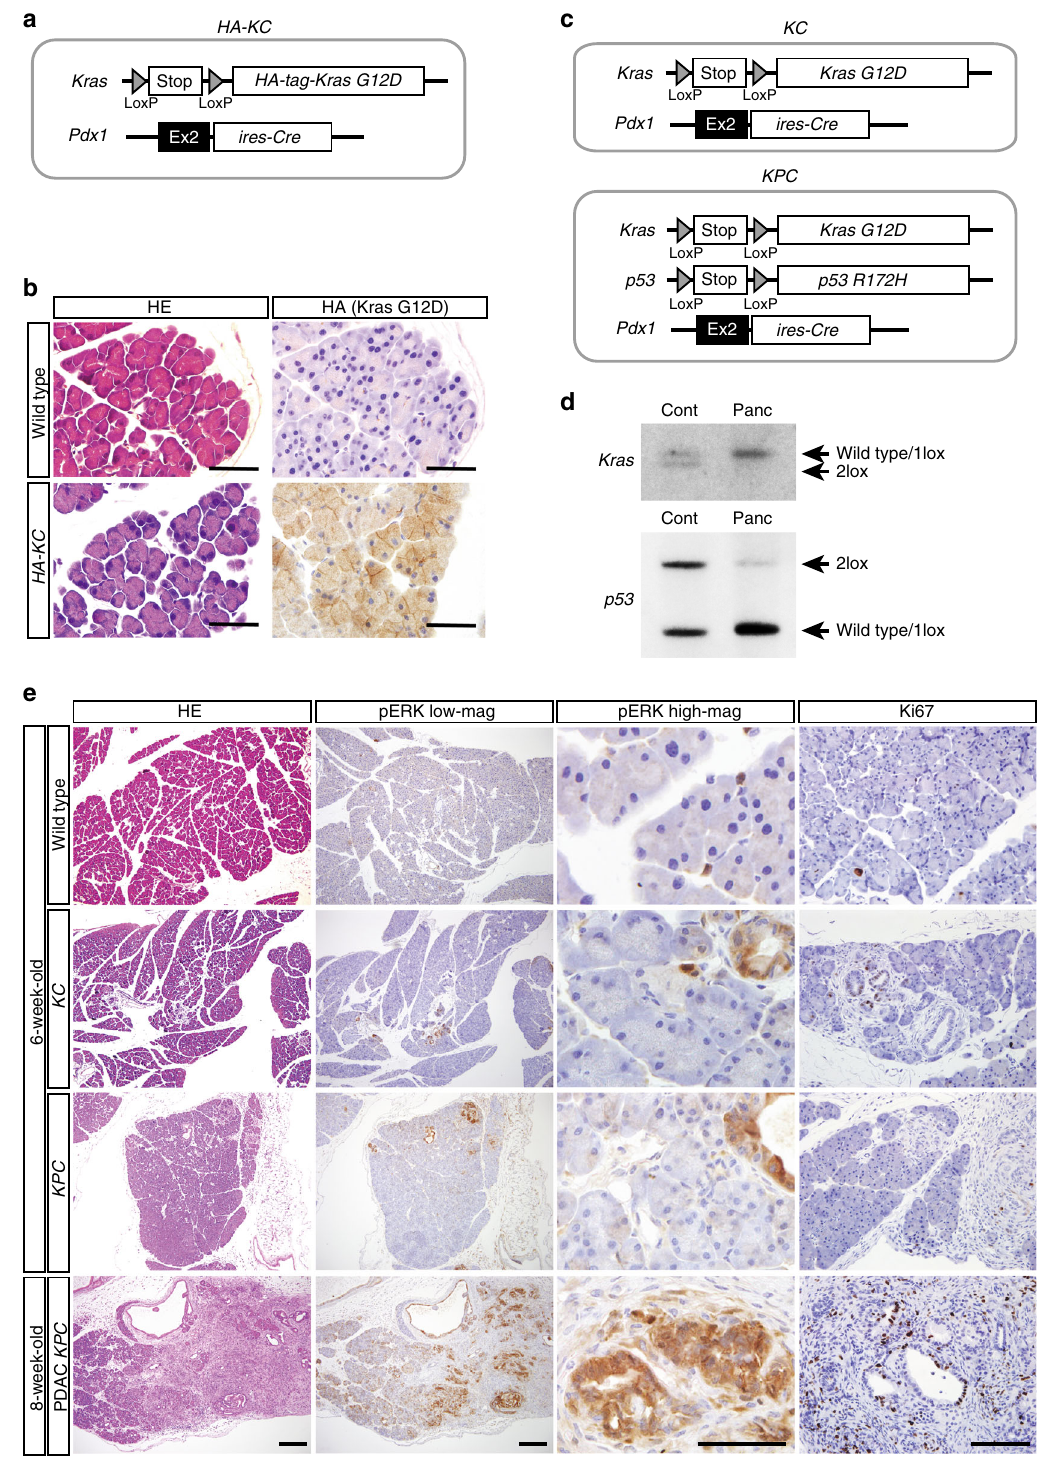
Fig. 1 Kras / p53 compound mutations are insuf fi cient for PDAC development. a A schematic illustration of the genetic construct to activate HA-Kras G12D in the pancreas. b Representative histology and immunostaining for HA-Kras G12D . Scale bars, 50 μ m. c Genetic strategy to study the in fl uence of somatic activation of Kras and p53 mutations in the pancreas. d Southern blotting of LSL-Kras G12D and LSL-p53 R172H allele. ESCs containing Pdx1 ires-Cre , LSL-Kras G12D and LSL-p53 R172H alleles were used as control. Note that majority of two LoxP alleles are converted into one LoxP allele in the pancreas of KPC mouse (Cont control, Panc pancreas). e Immunostaining for pERK and Ki67 in the pancreas of 6-week-old wild-type mice, KC mice, and KPC mice. KPC mice at 8 weeks of age showed a focal PDAC area with pERK staining (bottom). Scale bars: HE and pERK (low magni fi cation) staining, 200 μ m; pERK (high magni fi cation) staining, 50 μ m; and Ki67 staining, 100 μ